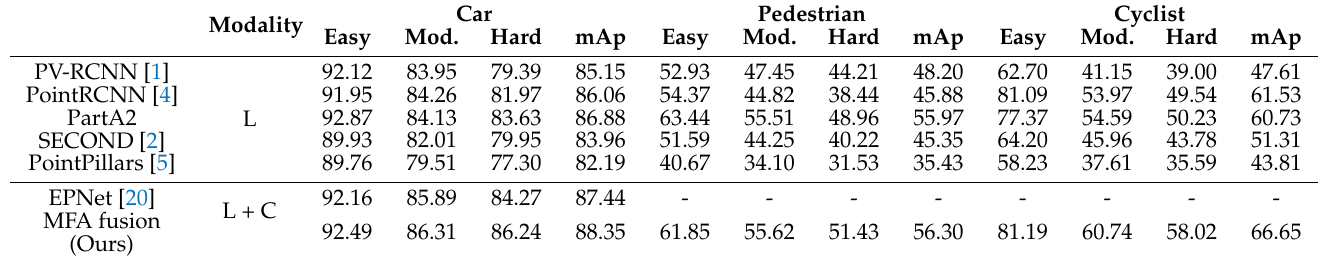
Table 2. Results of Bird’s Eye View (BEV) on the KITTI validation split with rain noise after training. Modality